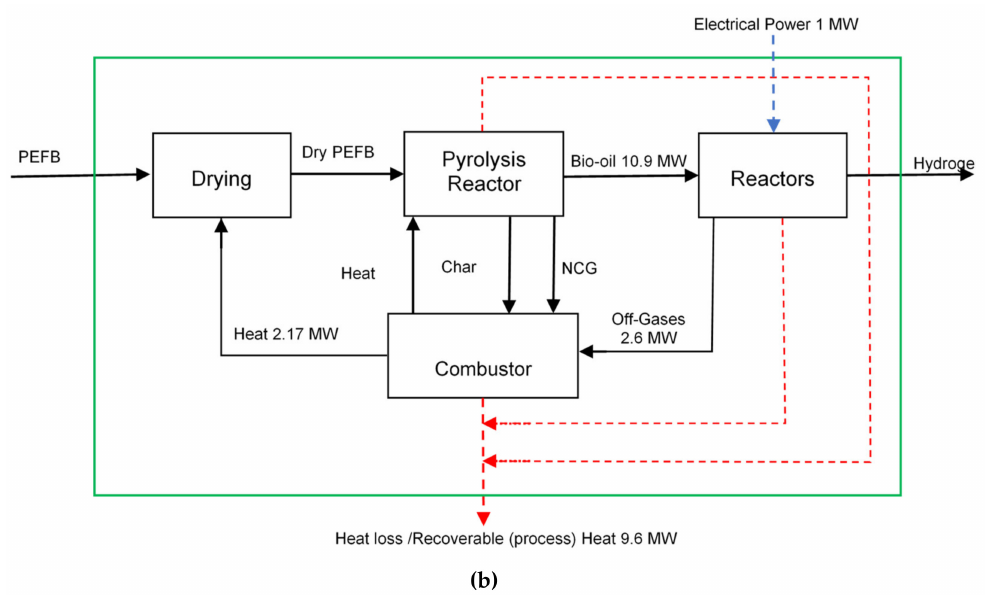
Figure 7. ( a ) Mass and ( b ) energy flows for 5000 kg/h biomass PAPS process plant with 75% H 2 recovered as pure gas at 10 bar. S/C = 2.2, λ = 0.28. Energy balance is based on LHV for 5000 kg/h biomass.